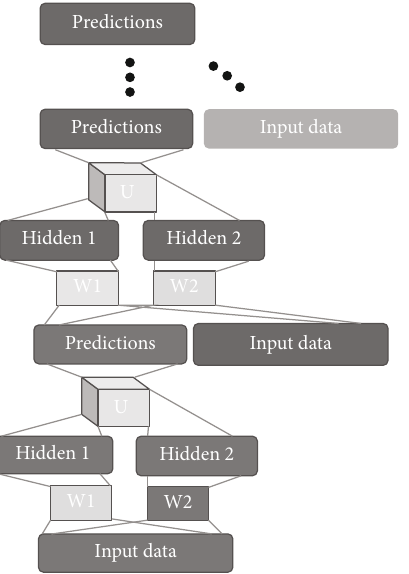
Figure 3: TDSN modules with prediction vector concatenating with input vector.